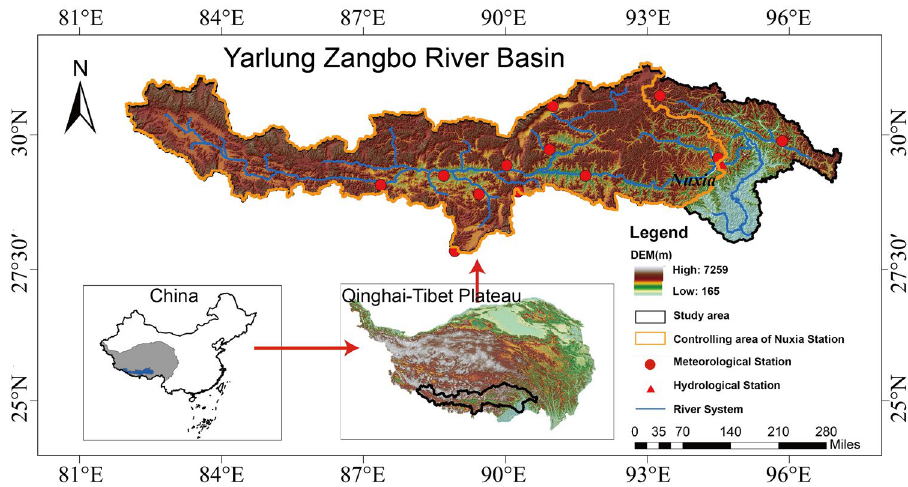
Figure 1. Location, topography and distribution of observation stations in YZRB (The software used to create the maps in Fig. 1, 2, 3, 4, 5 is ArcGIS10.4, http:// gisse rver. domain. com: 6080/